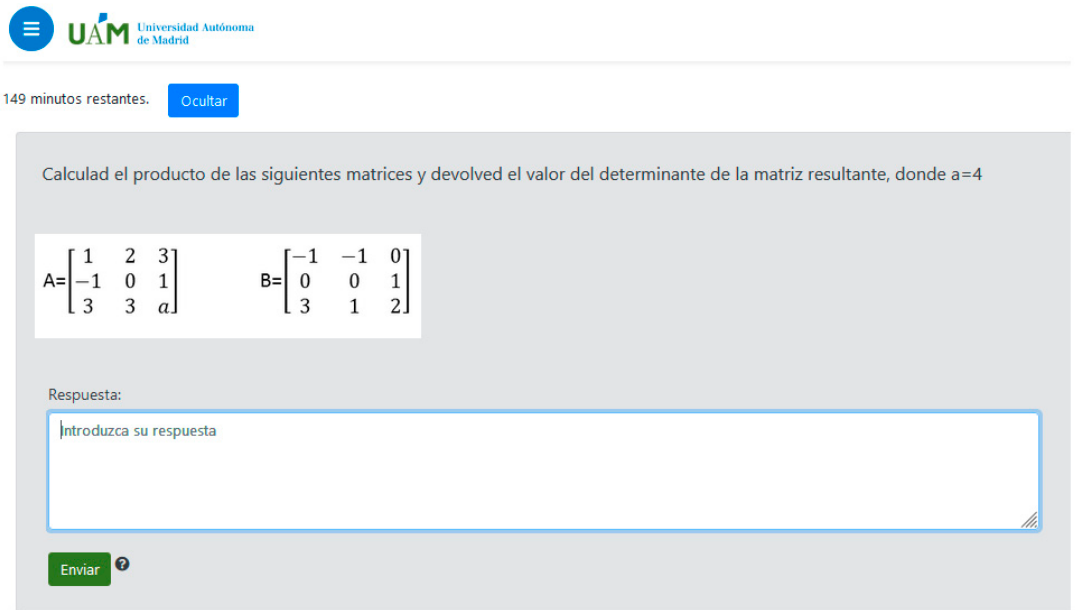
Figure 2. e-valUAM interface for students, showing one question from a self-evaluating test in the subject Applied Computing. The question in English would read “Calculate the product of the following matrices and return the value of the determinant of the resulting matrix, where a = 4”.